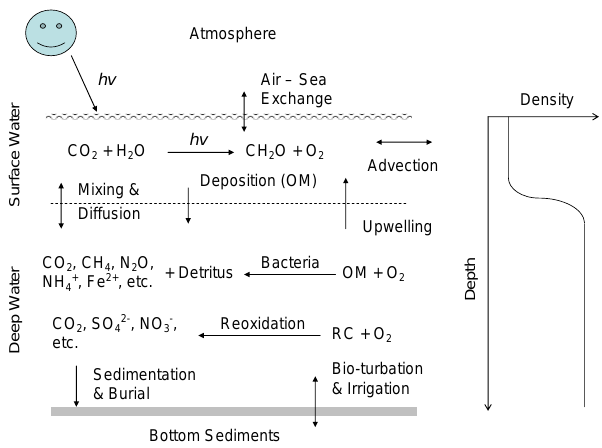
Figure 1. Fig. 1. Major mechanisms of production and consumption for dis- solved oxygen (DO) in the coastal environment. In surface waters, high DO can be maintained by photosynthesis (hv is photon en- ergy) and exchange with the atmosphere. Advection and turbulent mixing also affect the DO concentrations for a given water mass. In the deep part of the water column (e.g. beneath the pycnocline) and in bottom sediments, heterotrophic metabolisms (e.g. respira- tion), degradation of organic matter (OM), reoxidation of reduced constituents (RC) such as sulfide, methane etc., as well as chemoau- totrophy (e.g. oxidation of ammonium) consume DO with a variety of pathways and, when the consumption exceeds DO supply, hy- poxia